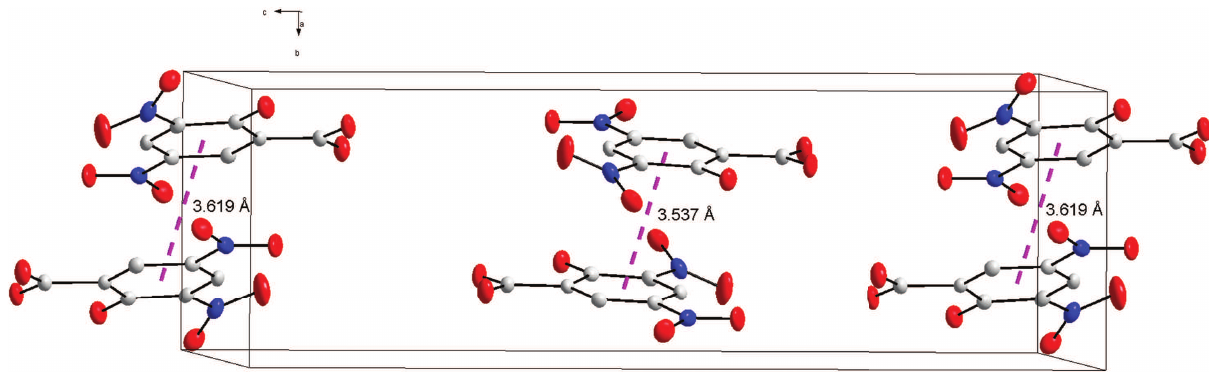
Figure 2: Observed π - π stacking in the crystal structure of tetraethylammonium 3,5-dinitrosalicylate, viewed along the a -axis. Cations and hydrogen atoms omitted for clarity.